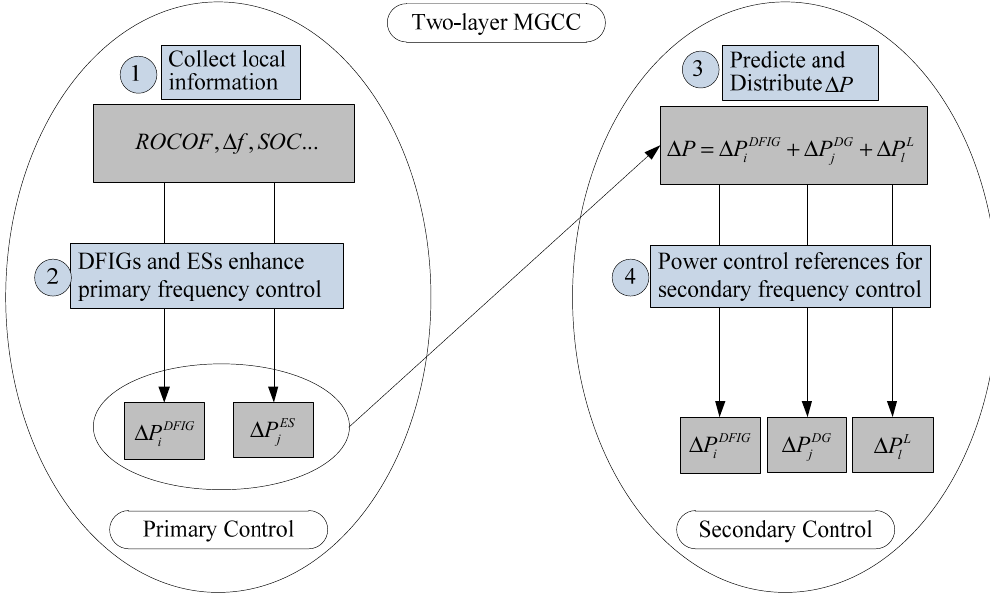
Figure 3. Flowchart of a two layered